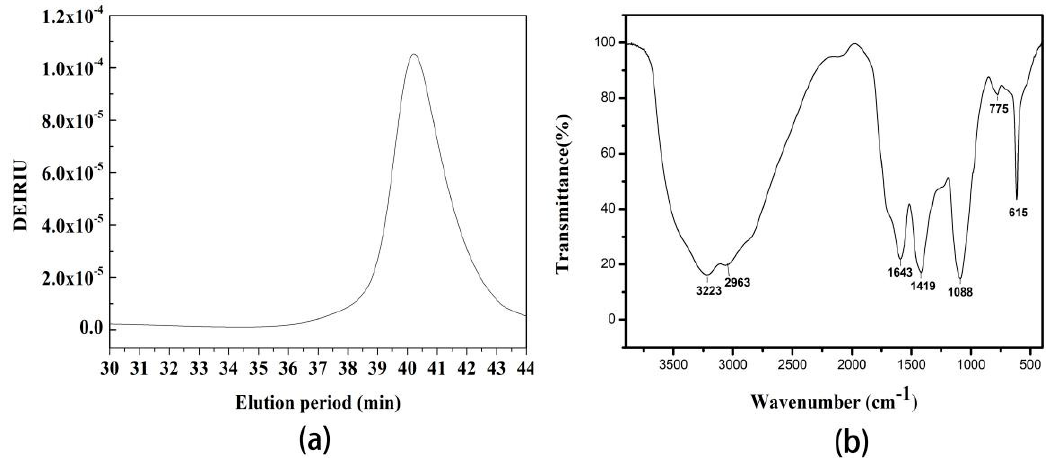
Figure 4. Physicochemical properties of the purified IOPS analyzed by ( a ) HPSEC-MALLS-RI chromatograms and ( b ) FT-IR spectrum.